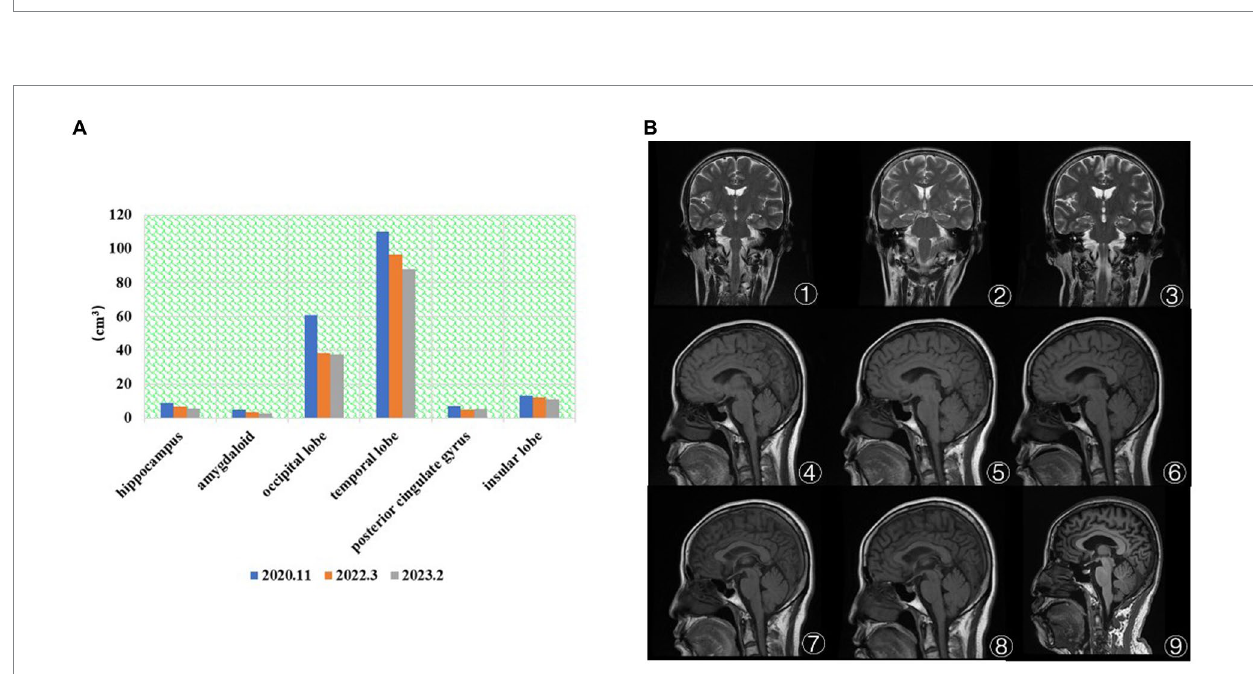
FIGURE 2 (A) The brain volume changes in regions of interest. The patient’s hippocampal, amygdala, occipital, temporal, and insula brain area volumes have gradually decreased over the last 3 years. (B) MRI results ( ① – ⑨ ). ① 2014.12 Coronal T2. ② 2017.7 Coronal T2. ③ 2018.3 Coronal T2. ④ 2014.12 Coronal